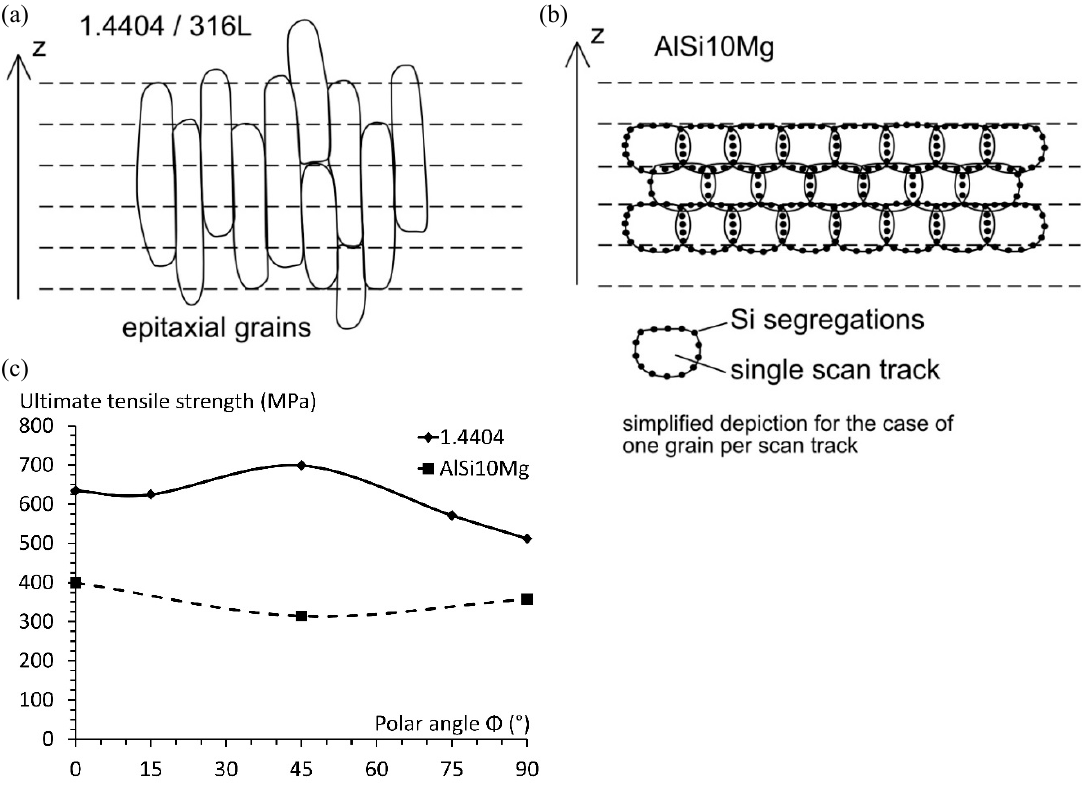
Figure 11. Comparison of the microstructural characteristics of ( a ) 1.4404 stainless steel and ( b ) AlSi10Mg, as well as their ( c ) strength dependency on the loading versus layer orientation [16].